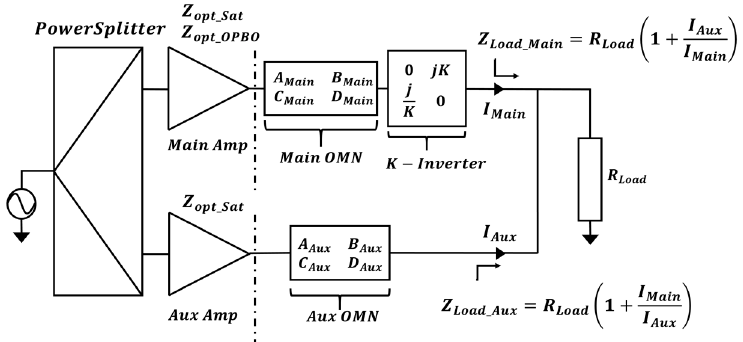
Figure 3. Simplified schematic of the proposed Doherty output combiner.